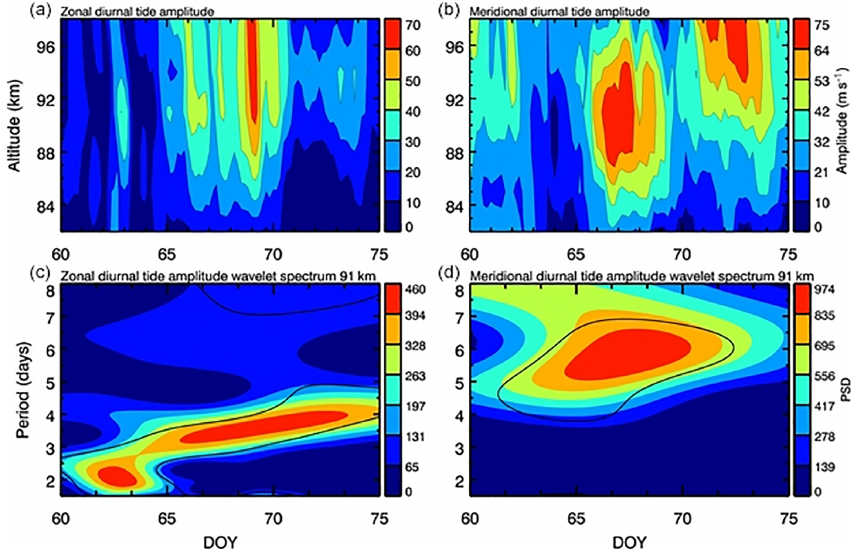
Figure 7. Diurnal tide amplitude in the zonal (a) and meridional (b) wind. Wavelet spectrum of the zonal and meridional diurnal tide amplitudes at